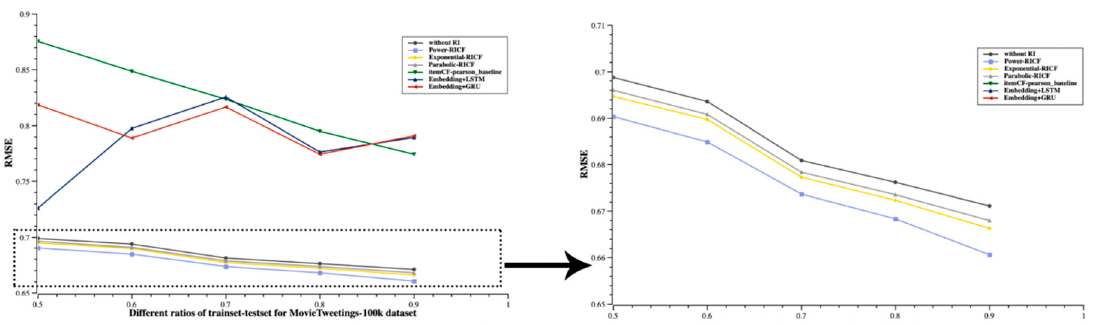
Figure 14. RMSE of seven algorithms on the MovieTweetings-100k dataset.